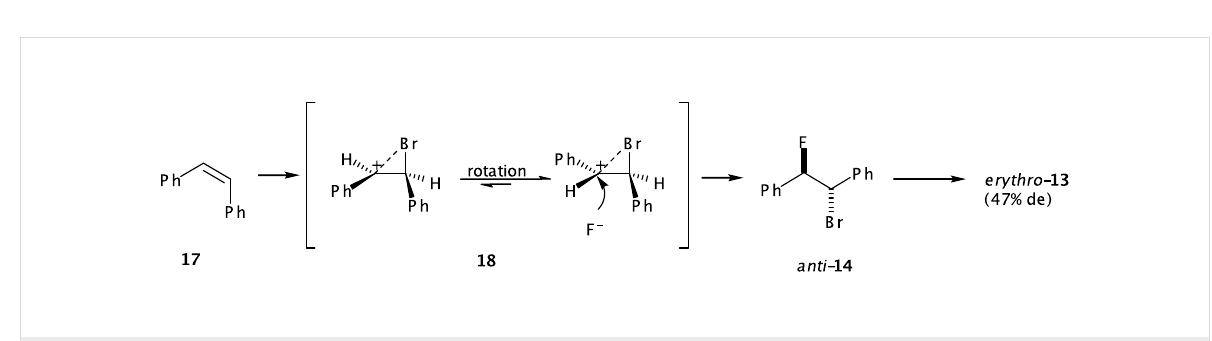
Scheme 7: Proposed C-C bond rotation during the preparation of 14 from cis -stilbene.